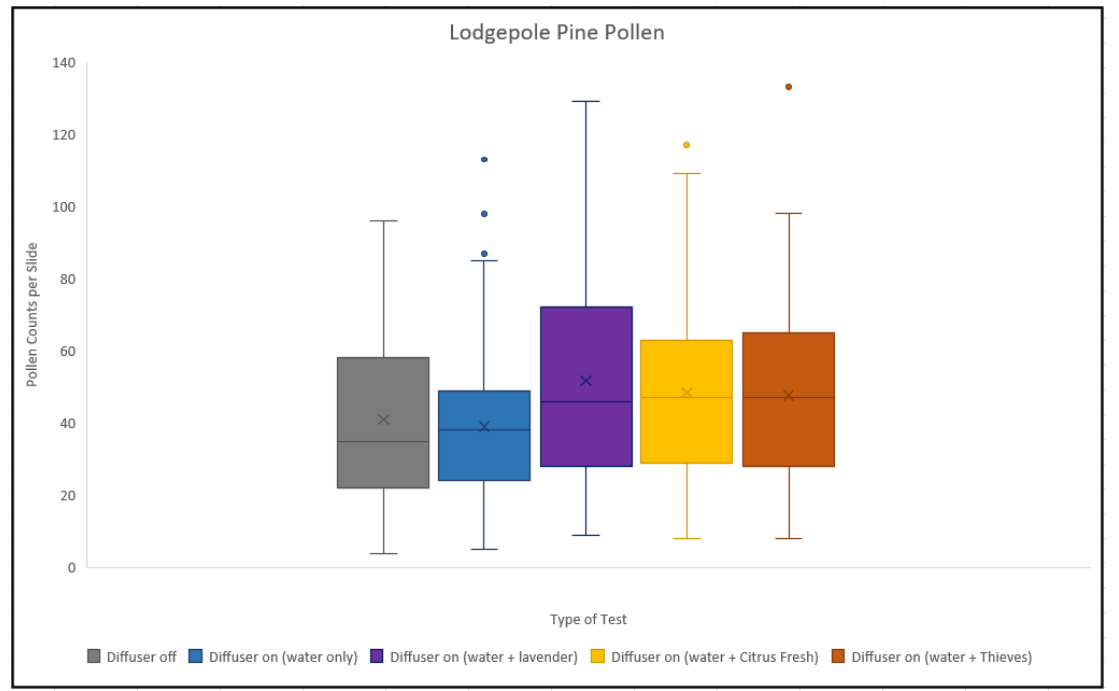
Figure 8. Total lodgepole pine pollen counts compared to test type.